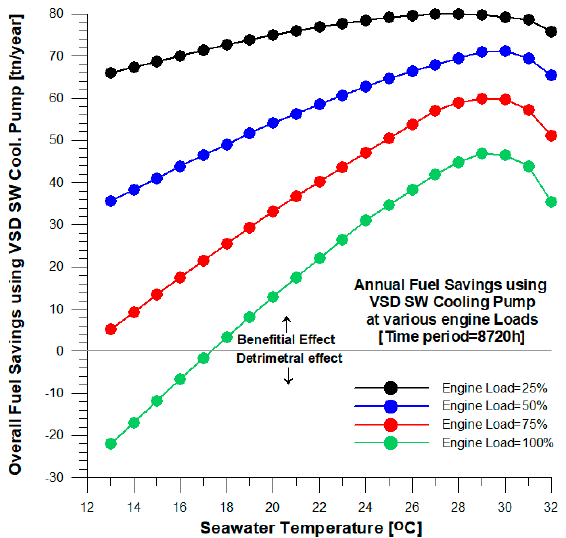
Figure 13. Comparison of the overall fuel savings (tn / year) obtained using a VSD instead of a conventional constant speed SW cooling pump at various engine loads as a function of the seawater temperature.